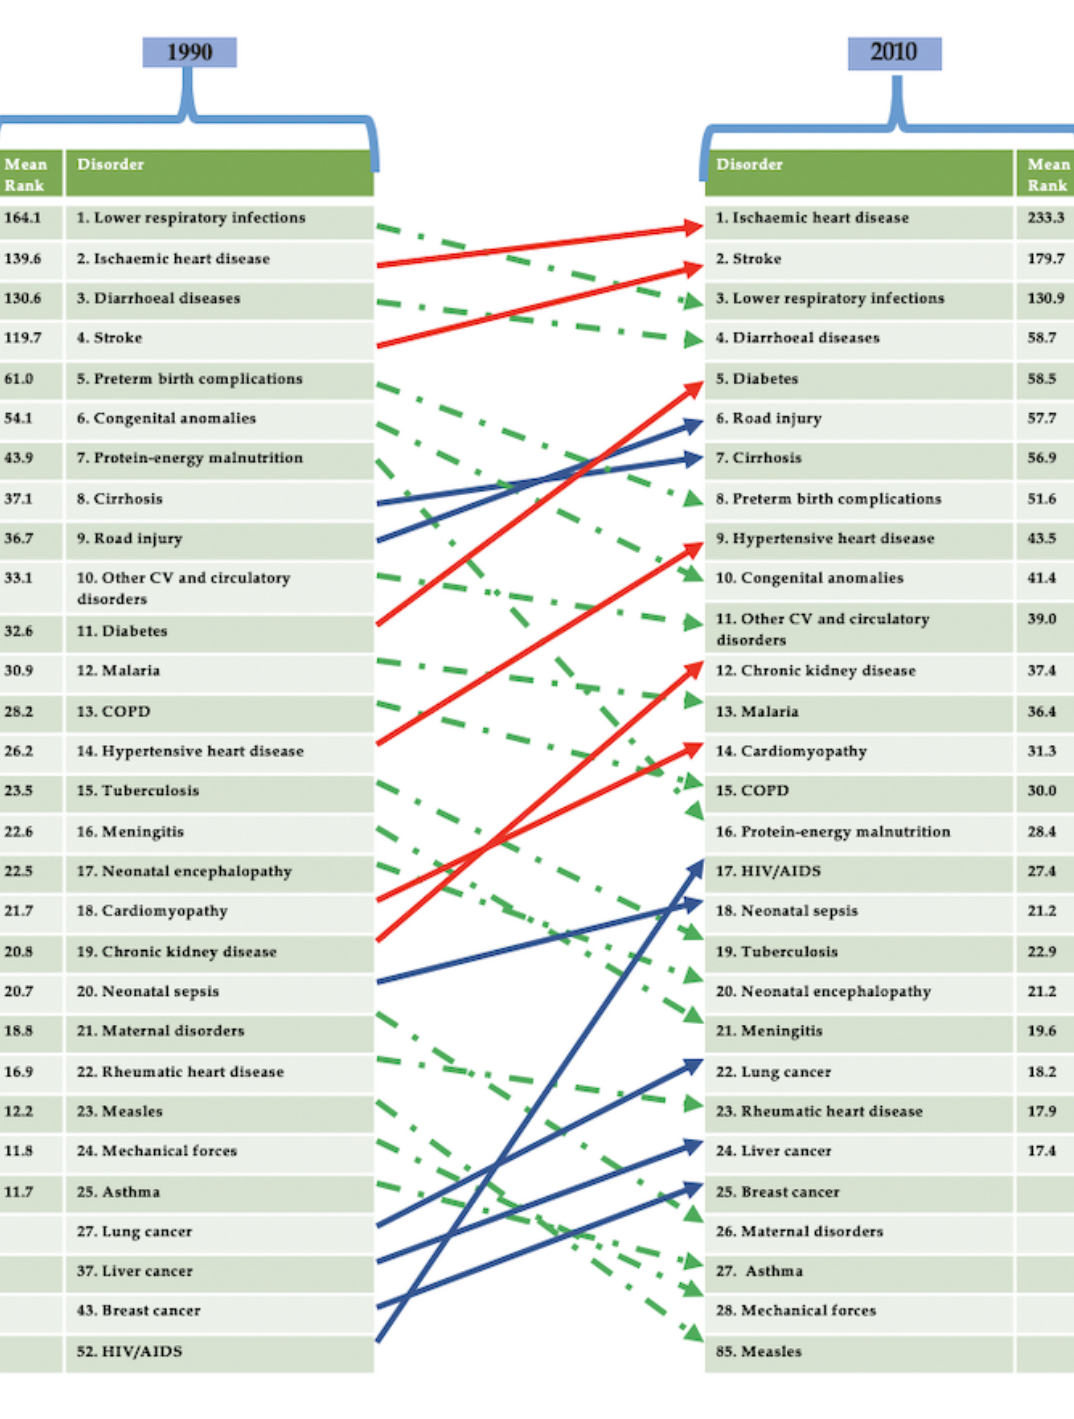
Figure 1. Top 25 causes of death in the Arab population in 1990 and 2010 (mean rank). A comparative analysis is provided. Solid blue lines indicate the elevation in rank for a condition or factor responsible for causing death in the Arab population from 1990 to 2010. Green dotted lines indicate a fall in rank of a condition or factor responsible causing death in the Arab population from 1990 to 2010. Red solid lines indicate the elevation or fall in rank of the factors contributing to cardiometabolic syndrome (CMS) in causing death from 1990 to 2010 (note: all the factors contributing to CMS are elevated in rank when compared between 1990 and 2010). Redrawn with modifications from Mokdad et al, 2014. COPD: chronic obstructive pulmonary disease; CV: